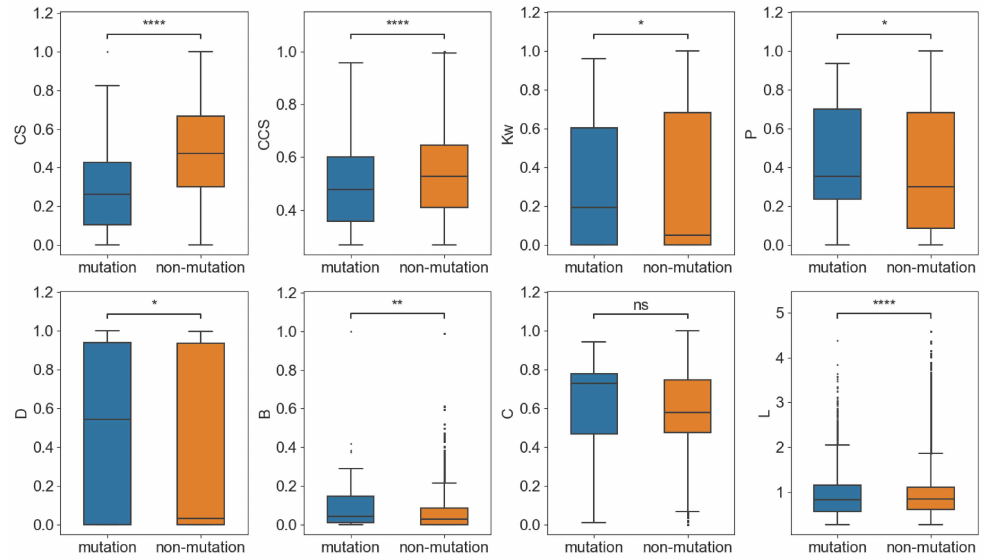
Figure 4. Comparison of the network features of the mutation and non-mutation sites. * p < 0.05; ** p < 0.01; **** p < 0.0001.